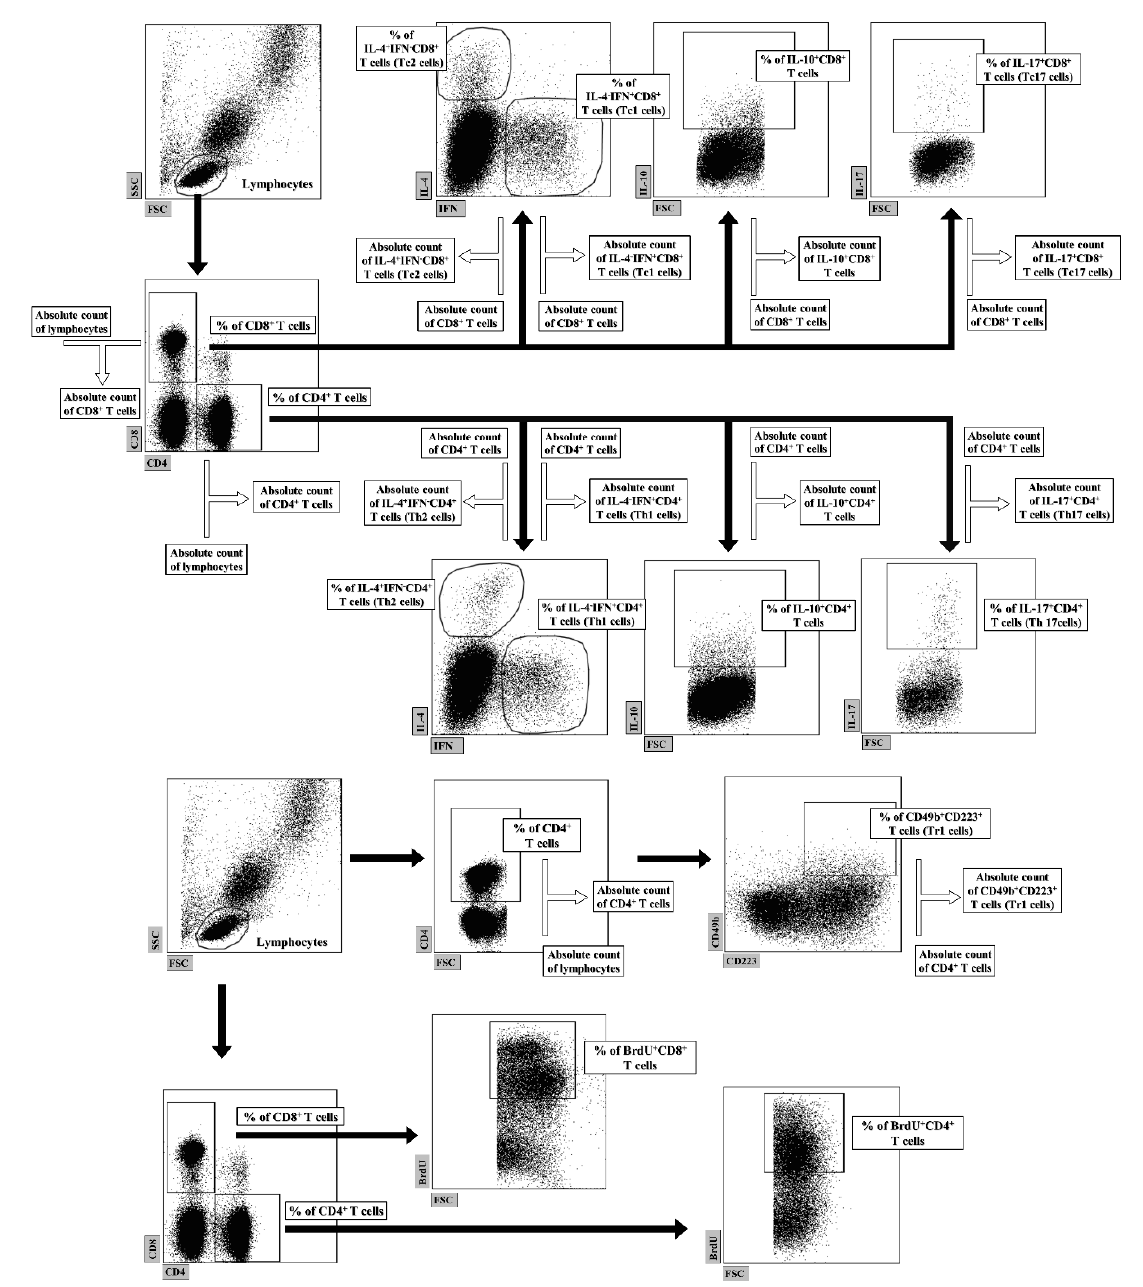
Figure 7. Gating strategy for flow cytometric data analysis and calculation of the absolute cell counts of lymphocyte subsets. Lymphocytes were identified based on forward and side scatter (FSC/SSC) properties, and then gated for expression of CD4 or CD8 surface receptors. Subsequently, IL-4-, IL-10-, IL-17- and IFN- γ -producing cells as well as CD49b + CD223 + -expressing and 5-bromo-2’-deoxyuridine(BrdU)-incorporating cells were identified within particular T cell subsets. Absolute cell counts of lymphocyte subsets (i.e., number of cells from particular subpopulations per sample well) were calculated using the dual platform method, as shown